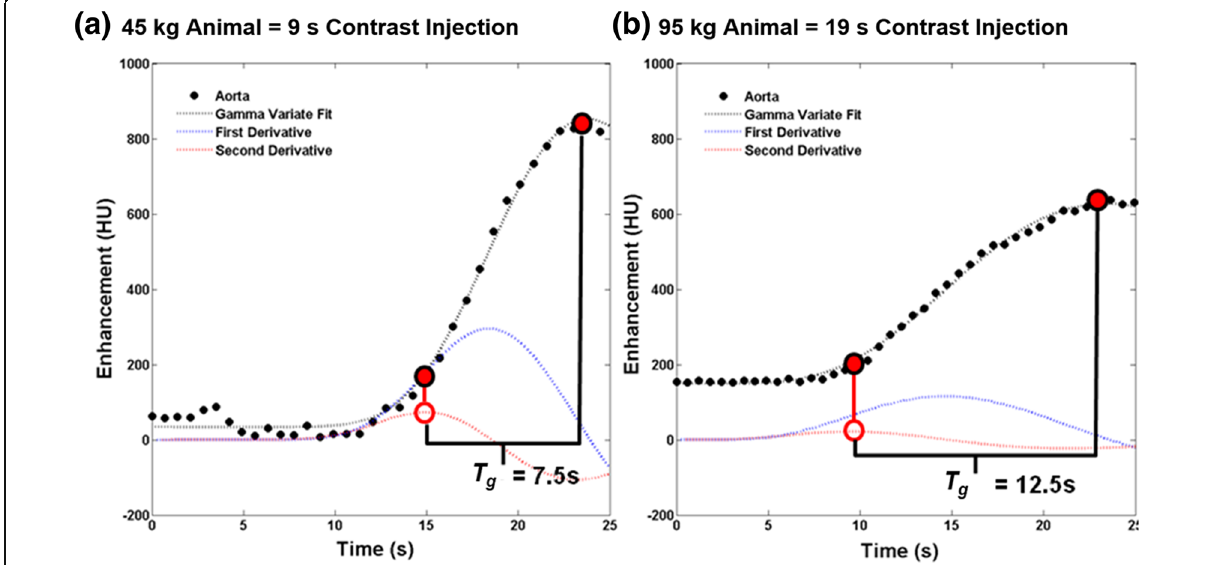
Fig. 2 Automatic gamma variate fitting of the aortic enhancement in two swine. a The gamma fit (black), first derivative (blue), second derivative (red), and time-to-peak ( T g ) are displayed for a 45-kg animal with a 9-s contrast injection. b The gamma fit (black), first derivative (blue), second derivative (red), and time-to-peak ( T g ) are also displayed for a 95-kg animal with a 19-s contrast